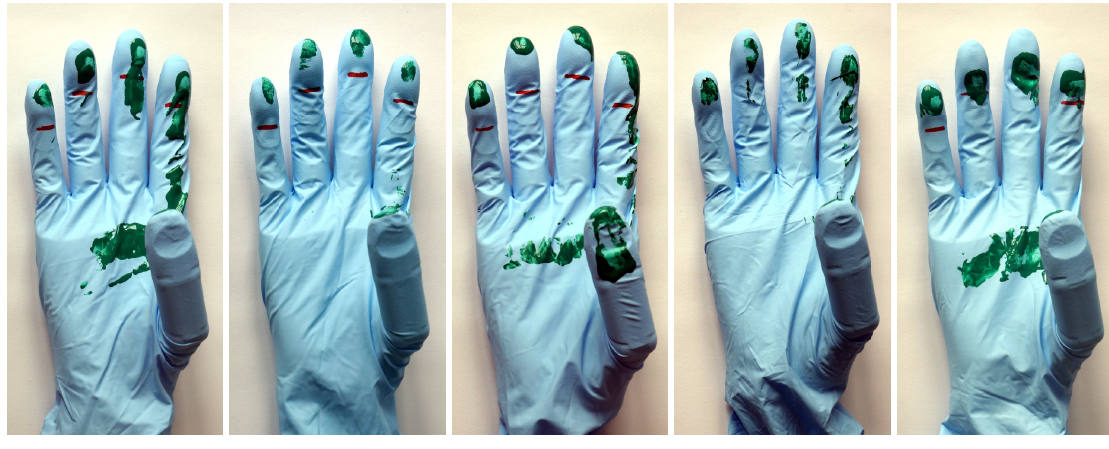
Figure 5. Examples of results from the finger contact surface experiment.